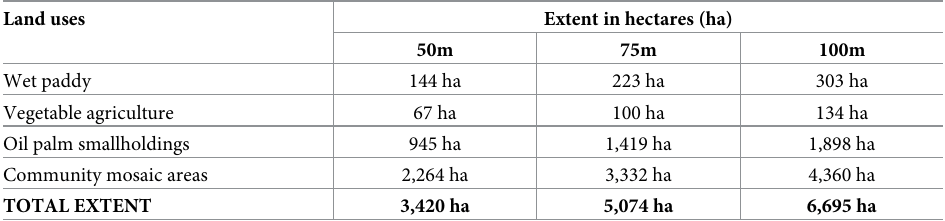
Table 3. Extents of community used lands within the Pan Borneo Highway path. Land uses Extent in hectares (ha) 50m 75m 100m Wet paddy 144 ha 223 ha 303 ha Vegetable agriculture 67 ha 100 ha 134 ha Oil palm smallholdings 945 ha 1,419 ha 1,898 ha Community mosaic areas 2,264 ha 3,332 ha 4,360 ha TOTAL EXTENT 3,420 ha 5,074 ha 6,695 ha